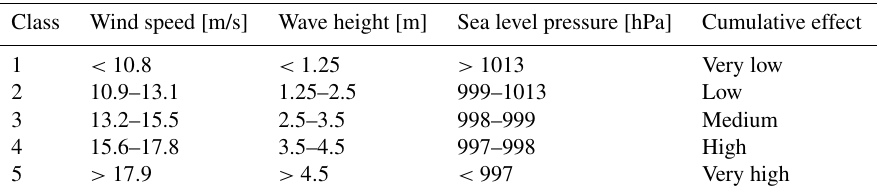
Table 1. Classification in five classes of the three marine weather parameters – WS s , Hs s , and SLP s – and classification of their cumulative coastal effects. Class Wind speed [m/s] Wave height [m] Sea level pressure [hPa] Cumulative effect 1 < 10 . 8 < 1 . 25 >